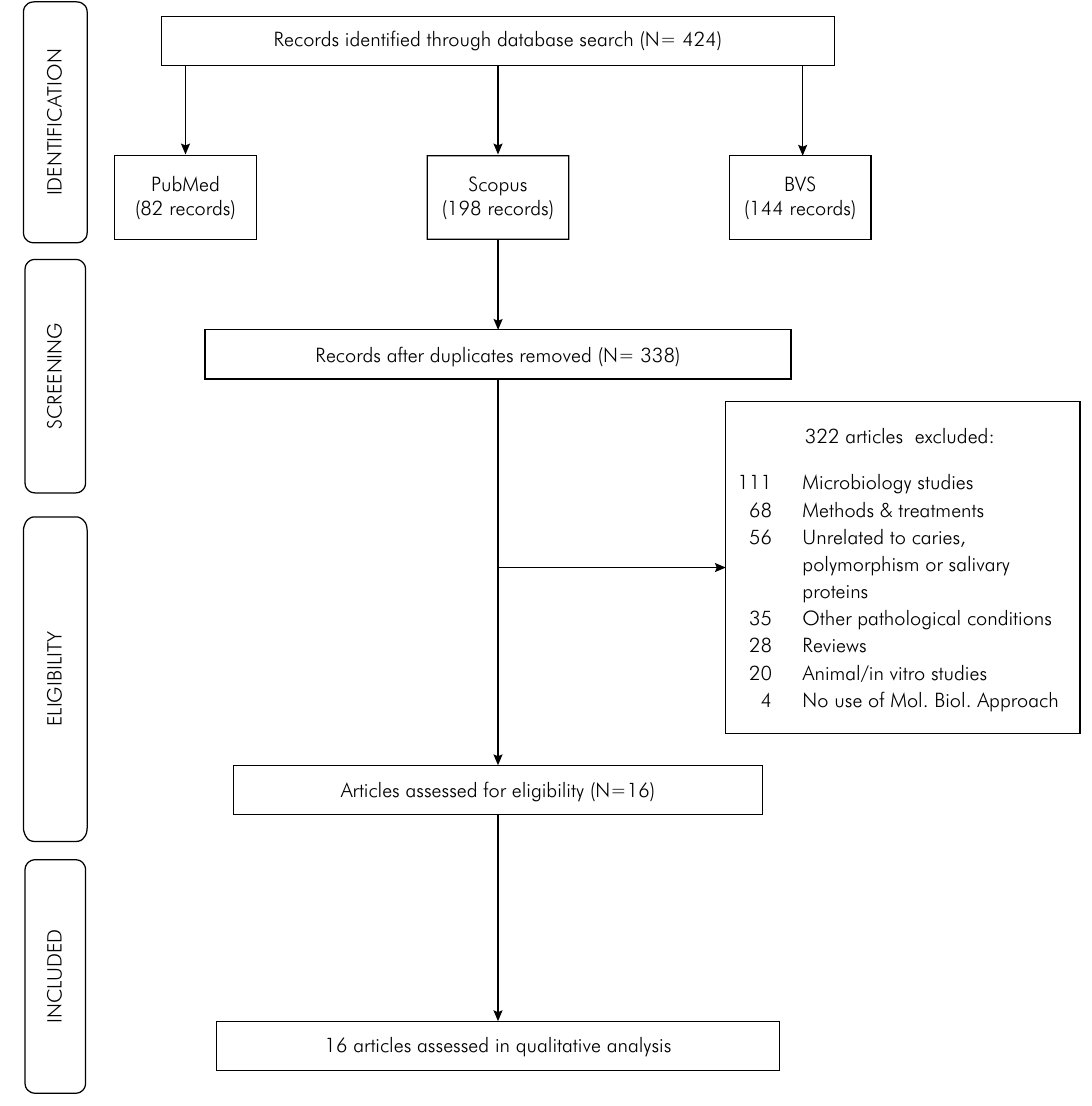
Figure 3. Summary of systematic steps according to Prisma Statement